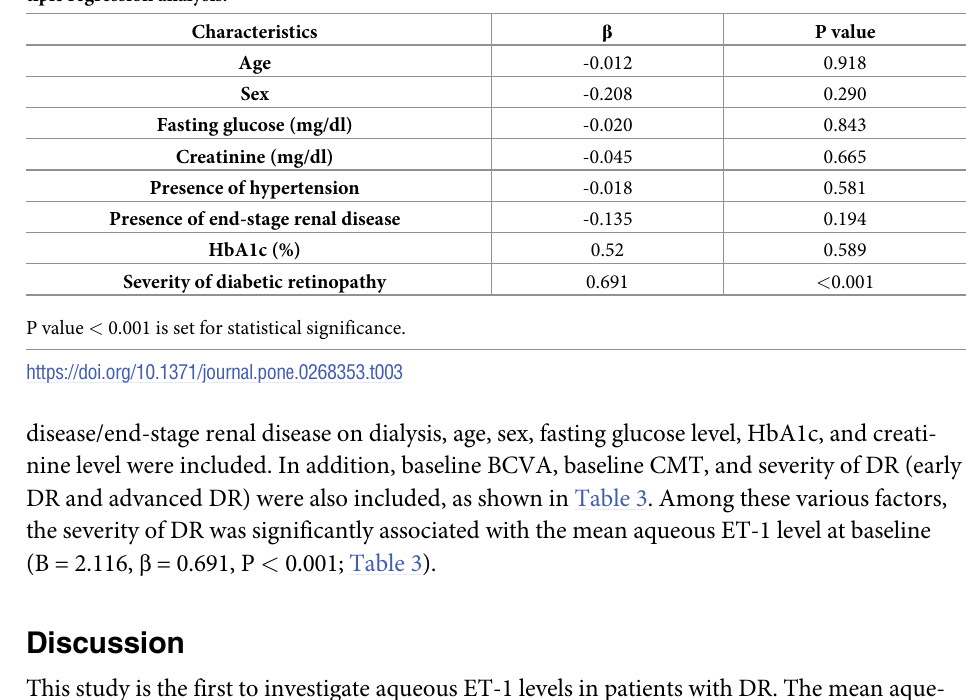
Table 3. The possible factors associated with the mean aqueous endothelin-1 level in the study population by mul- tiple regression analysis. Characteristics